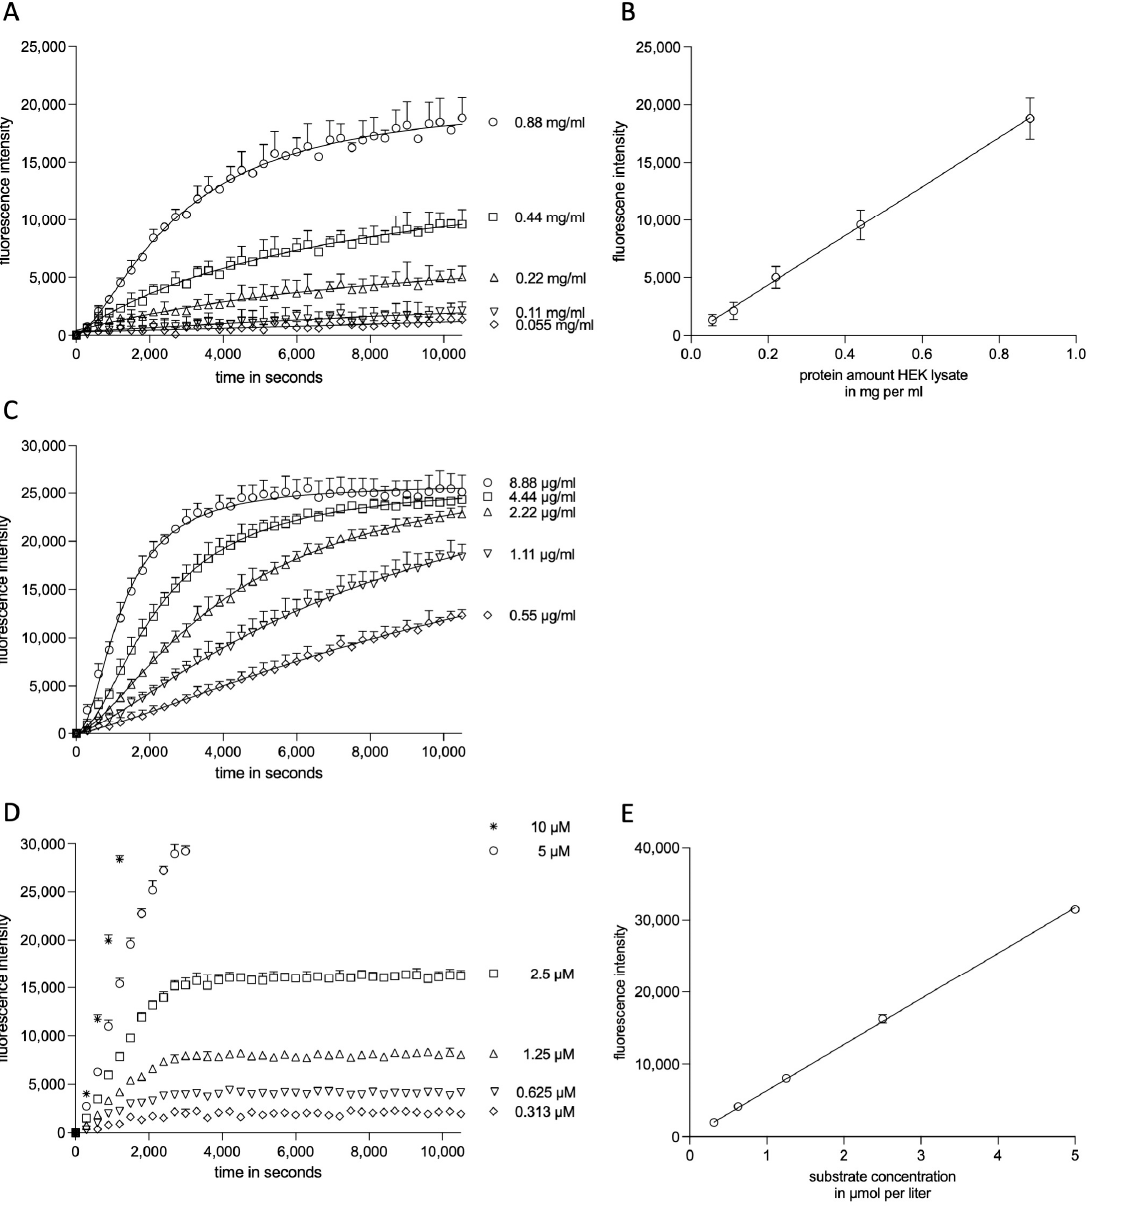
Figure 1. Experimental kinetic modeling setup. HEK cell lysates were probed for cleavage of substrate II at varying protein concentrations ( A ), 2.5 µ M substrate concentration) and analyzed for linearity ( B ), indicating working at substrate saturation/excess). Determination of total substrate turnover by 1ST3 ( C ), 2.5 µ M substrate concentration) and at varying substrate concentrations ( D ) for linear regression ( E ). In ( D ), only data in range are shown (detection limit without baseline subtraction: 50,000). In ( E ), the highest substrate concentration (10 µ M) was not implemented as the total substrate turnover could not be achieved/measured. The kinetic measurements ( A , C , D ) and linear regressions are shown as mean +/ ± SD of three independent experiments. In ( A , C , D ), enzyme kinetic velocity fitting was